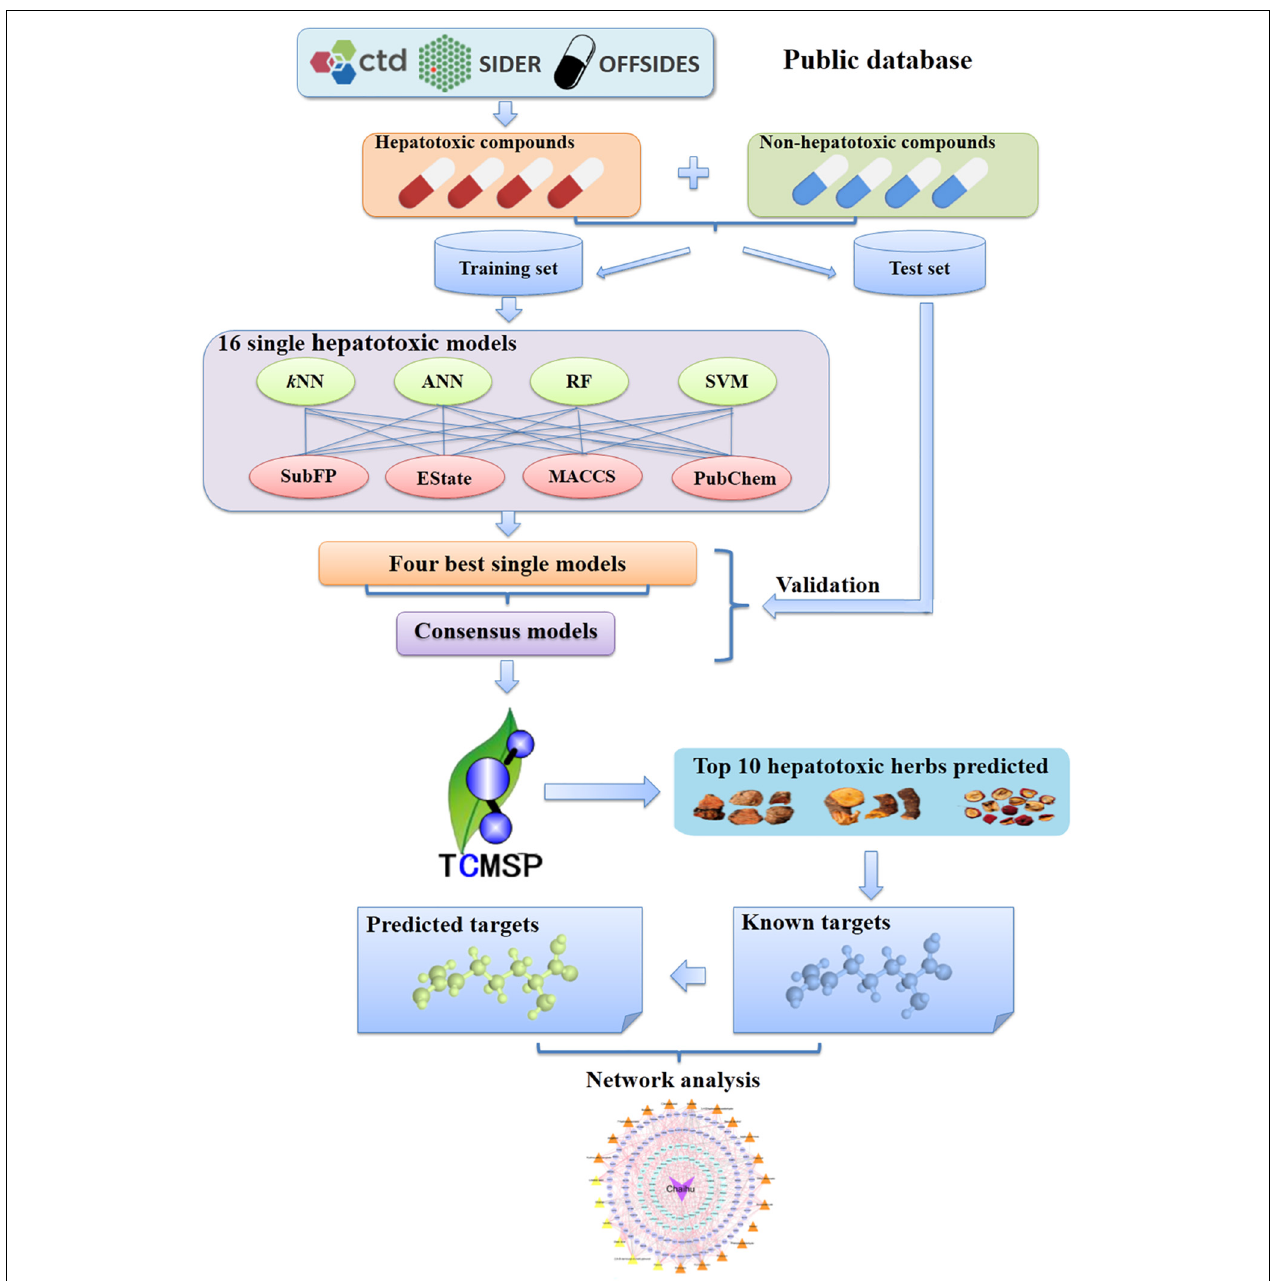
FIGURE 1 | Schematic diagram of models building, identification of potential hepatotoxic ingredients and unraveling the hepatotoxicity mechanisms based on systems pharmacology approaches. CTD, Comparative Toxicogenomics Database; k NN, k -nearest neighbor; ANN, artificial neural network; RF, random forest; SVM, support vector machine; SubFP, Substructure fingerprint; EState, EState fingerprint; MACCS, MACCS Keys fingerprint; Pubchem, PubChem fingerprint; TCMSP, the Traditional Chinese Medicine systems pharmacology database and analysis